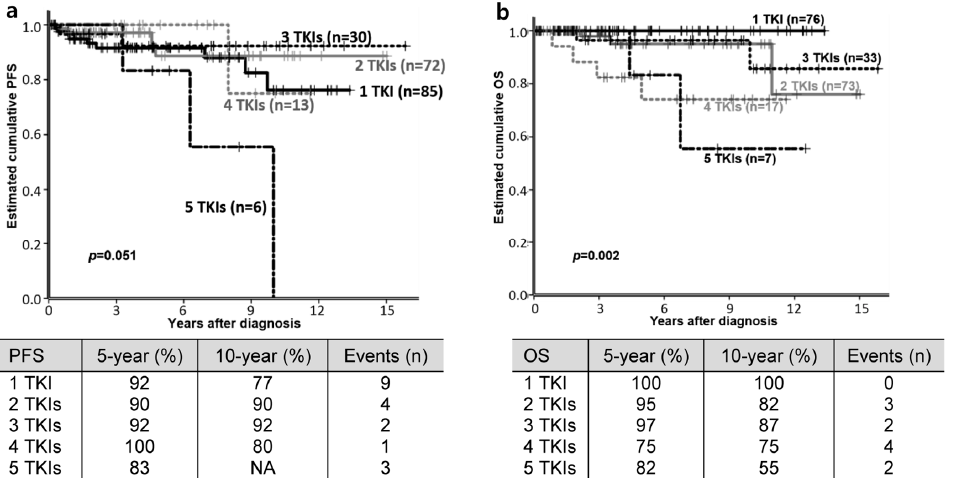
Figure 1. Estimated cumulative progression free survival (PFS) ( a ) and overall survival (OS) rate ( b ) of chronic phase chronic myeloid leukemia patients according to the number of treated tyrosine kinase inhibitors (TKIs). (Since 15 patients were treated with a median of 1.5 (1–3) or more TKIs